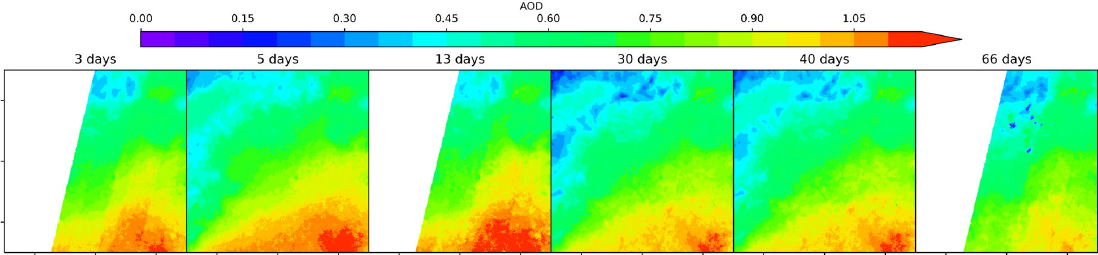
Figure 7. The retrieval AOD distribution maps of 24 October 2020 based on different reference images. From left to right, the time difference between the reference image and the retrieval image is 3 days, 5 days, 13 days, 30 days, 40 days, and 66 days.